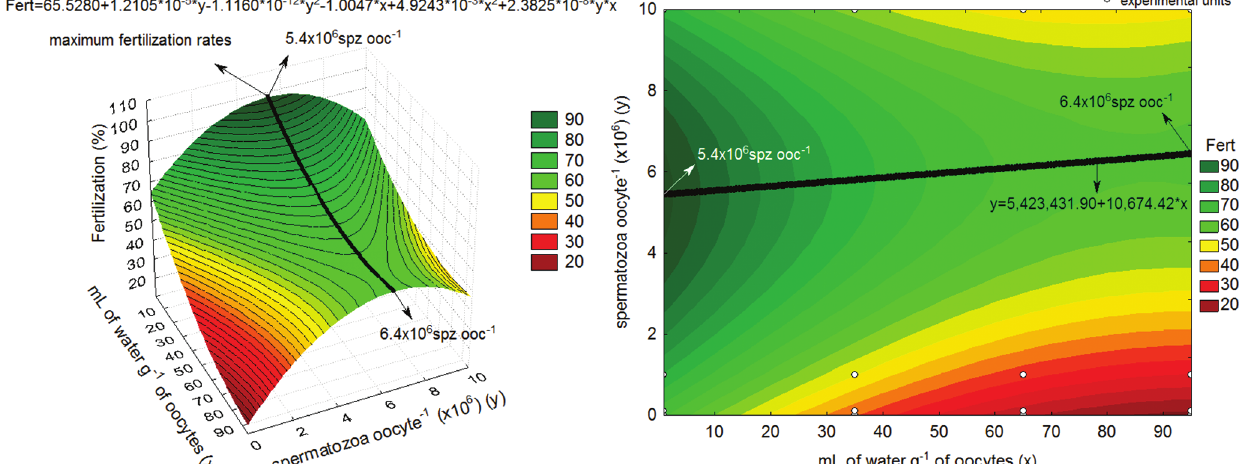
Fig. 1. Values of fertilization rates (Fert) of Steindachneridion parahybae with regard to different inseminating doses versus water volume. Left – 3D graphical representation. Right – 2D graphical representation. Spermatozoa oocyte -1 (spz ooc -1 ). r²=77.47%.